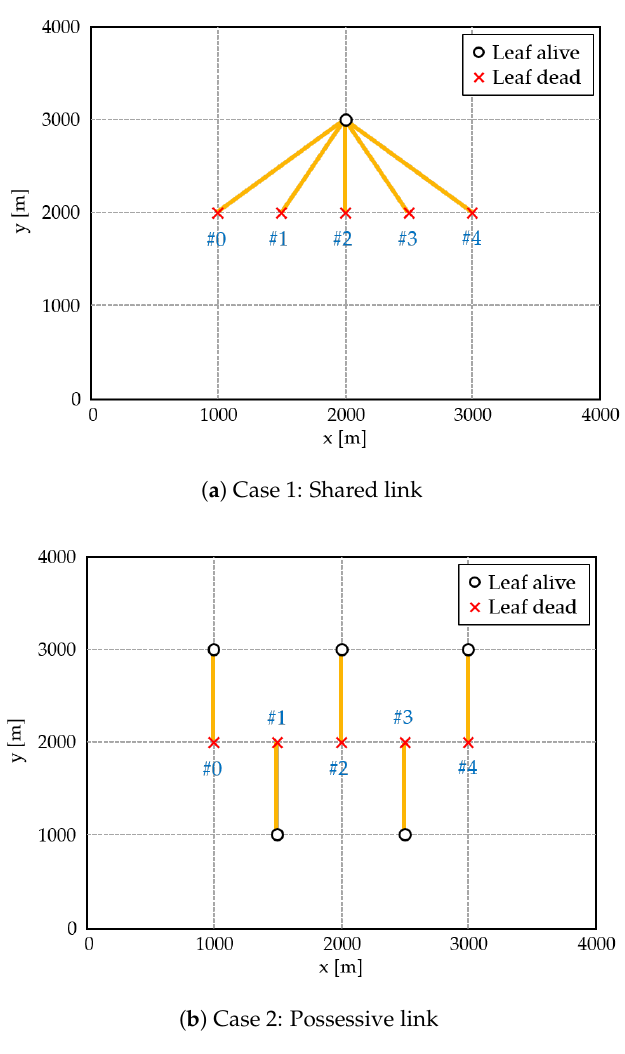
Figure 4. Simplified topology and routing